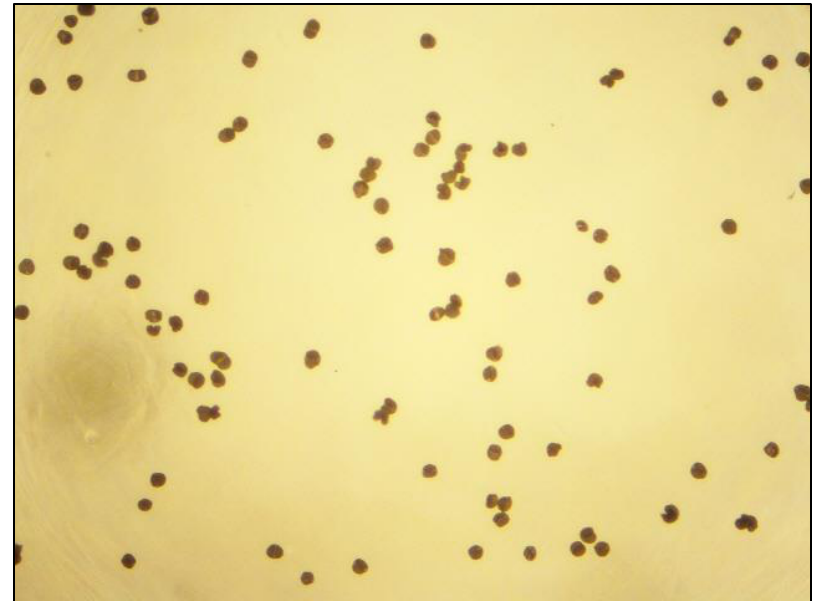
Figure 4. Lodgepole pine pollen distribution on the surface of the